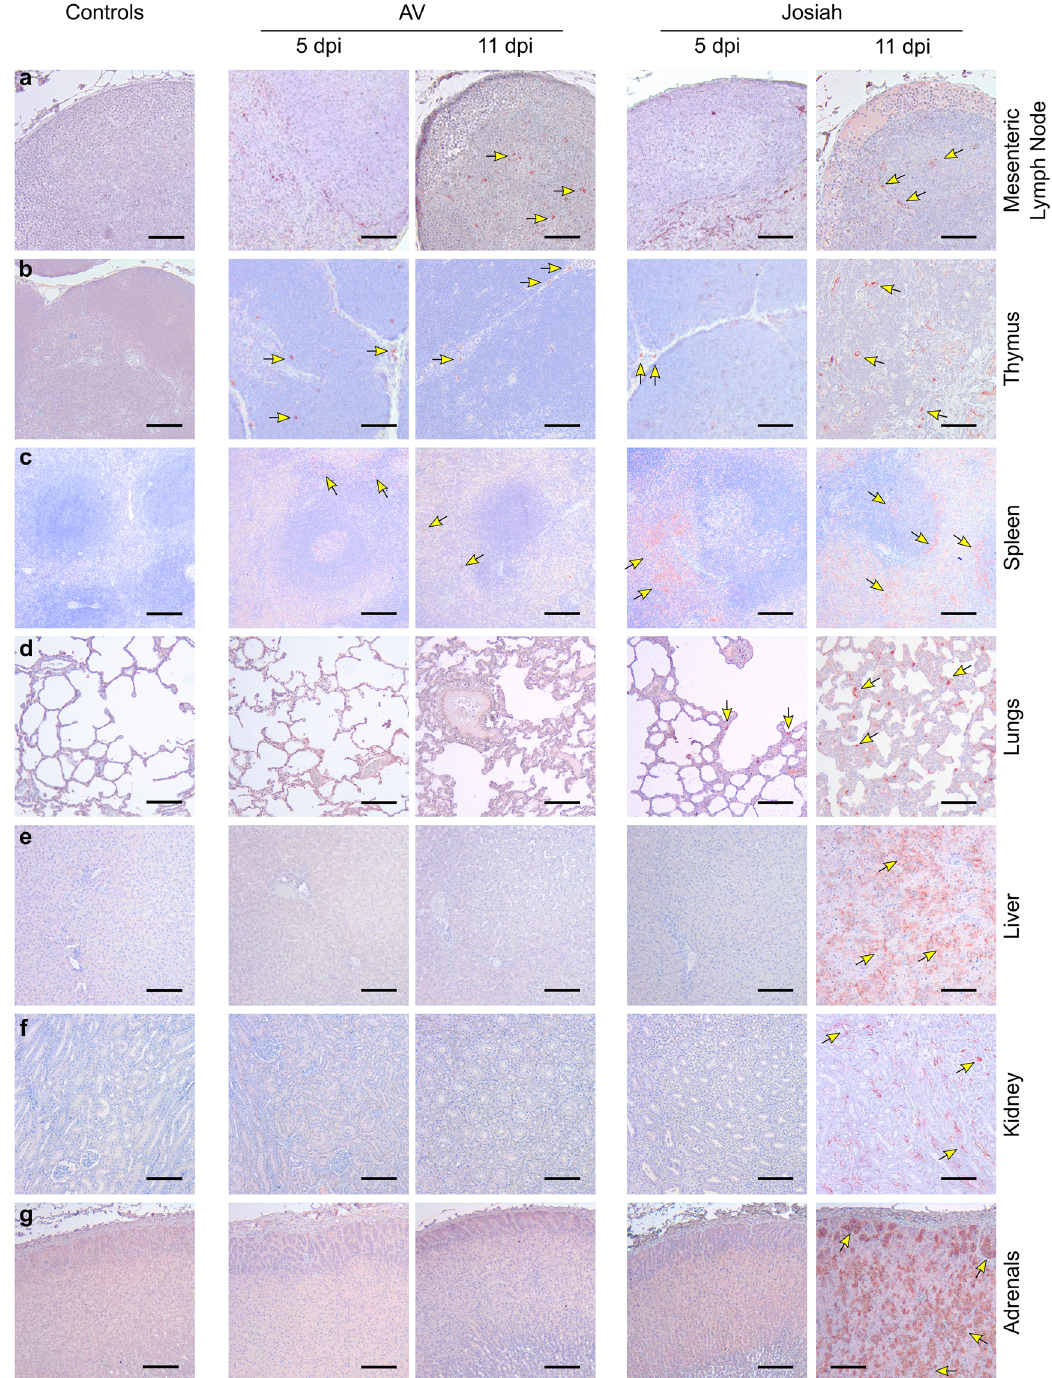
Fig. 2 Examples of LASV spreading as a function of the severity of the disease. Immunohistochemistry of LASV-GP (red) during the course of the disease in a MLNs, b thymus, c spleen, d lungs, e liver, f kidneys, and g adrenal glands. a , b Scale bars: 100 µ m. c – g Scale bars: 200 µ m. Key immunohistological features are indicated by